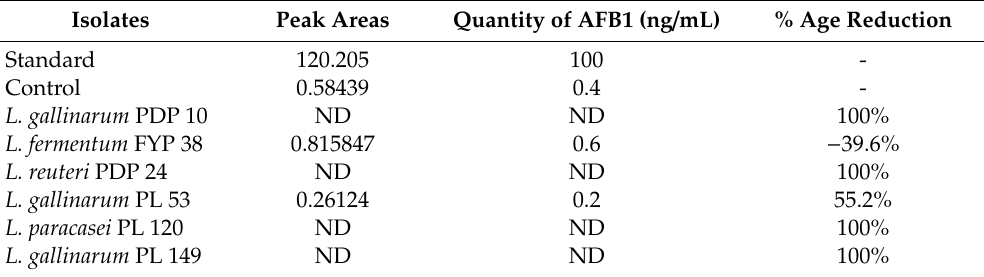
Table 2. E ff ect of lactobacilli on aflatoxin B1 production.